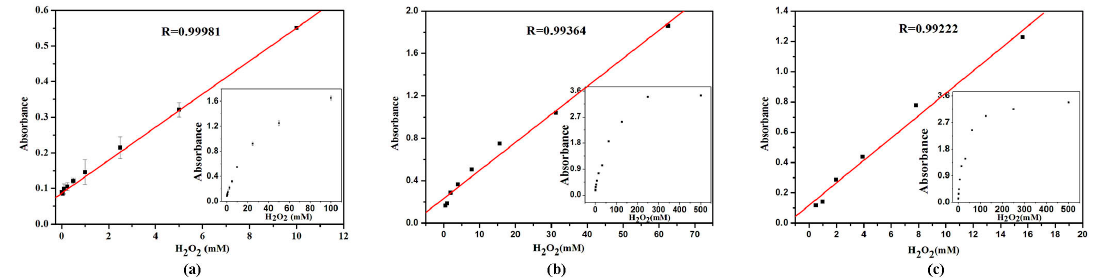
Figure 8. A dose-response curve depending of the absorbance at 656 nm in the presence of different concentrations of H 2 O 2 . ( a ) VO 2 nanofibers; ( b ) VO 2 nanosheets; ( c ) VO 2 nanorods. Error bars represent the standard deviation of three measurements. Conditions: pH, 4.0 (0.2 M citrate buffer); temperature, 25 °C; incubation time, 5 min.